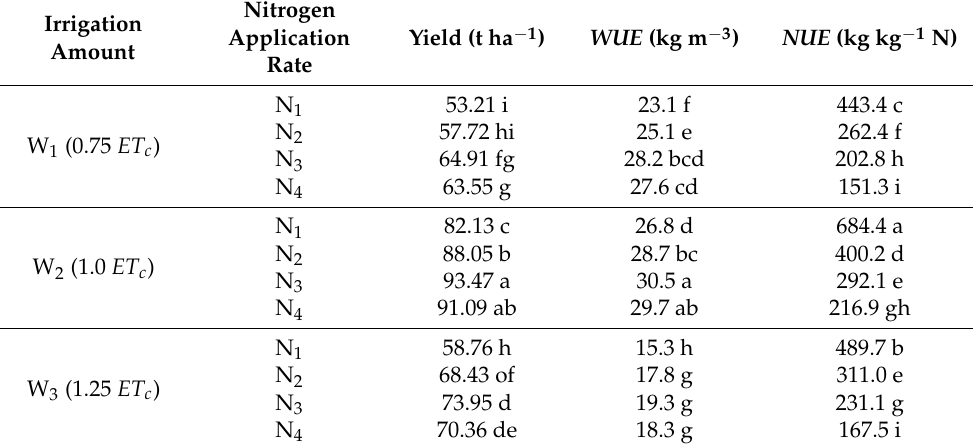
Table 4. Effects of different water and nitrogen levels on yield, WUE , NUE of greenhouse tomatoes. Irrigation Amount